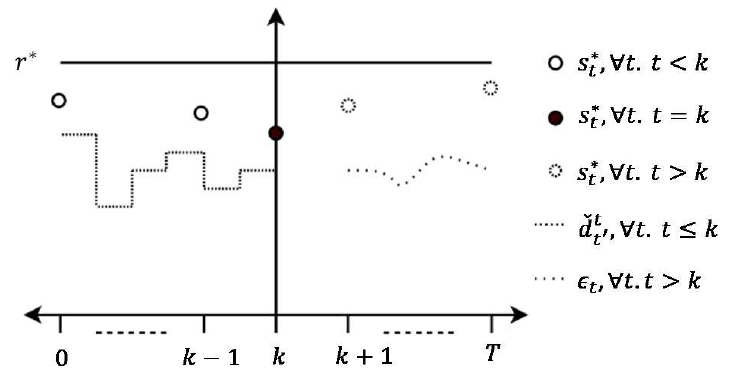
Figure 5. Expected Load Flattening (ELF)